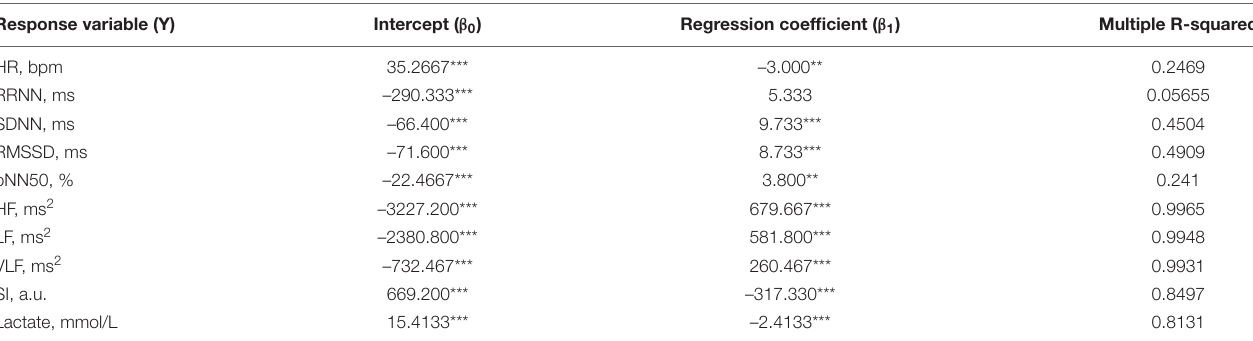
FIGURE 2 | Correlation matrix for displaying the relationship between the changes in HRV parameters and blood lactate levels under HIIE conditions in both intervention groups. n = 15 per group. HR, heart rate; RRNN, mean RR normal-to-normal intervals; SDNN, standard deviation of normal-to-normal intervals; RMSSD, root mean square of successive RR intervals differences; pNN50, percentage of successive RR intervals that differ by more than 50 ms; HF, absolute power of the high-frequency band; LF, absolute power of the low-frequency band; VLF, absolute power of the very-low-frequency band; SI, stress index; RJQ, royal jelly plus coenzyme Q10; PLA, placebo. TABLE 2 | Modeling the effects of 10-day RJQ supplementation on changes in HRV parameters and blood lactate levels in response to high-intensity interval